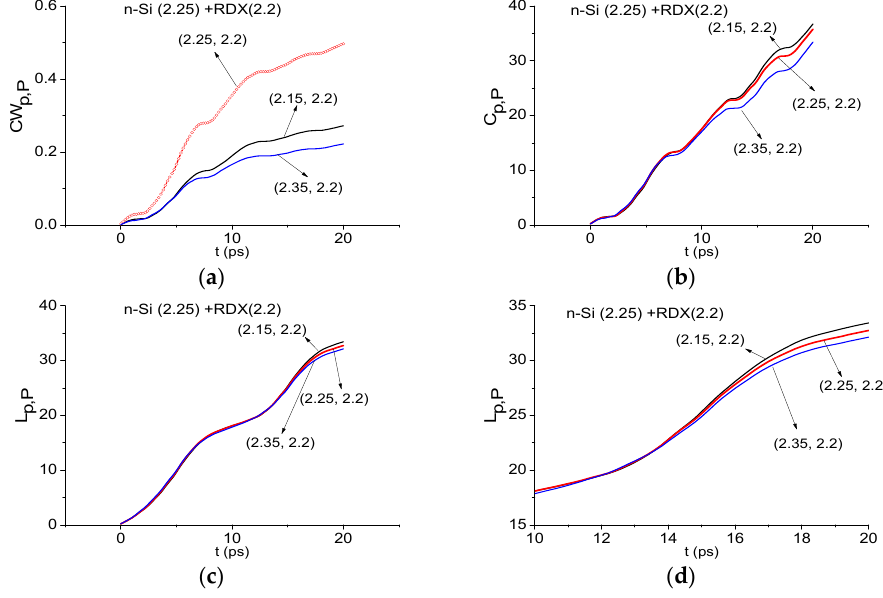
Figure 12. Integral characteristics CW p,P ( t n ) ( a ); C p,P ( t n ) ( b ); L p,P ( t n ) ( c , d ) calculated for the frequency ν = 2.25 THz for n-Si signal with RDX_Air as a standard one.